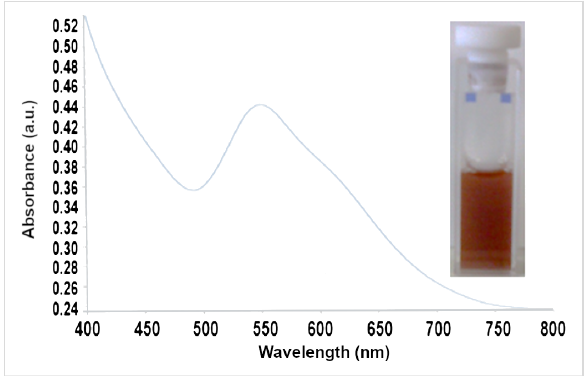
Figure 2: The visible spectrum of the colloidal suspension of Au NPs in water (inset on the right) obtained from compound 4 . Characterization of gold nanoparticles